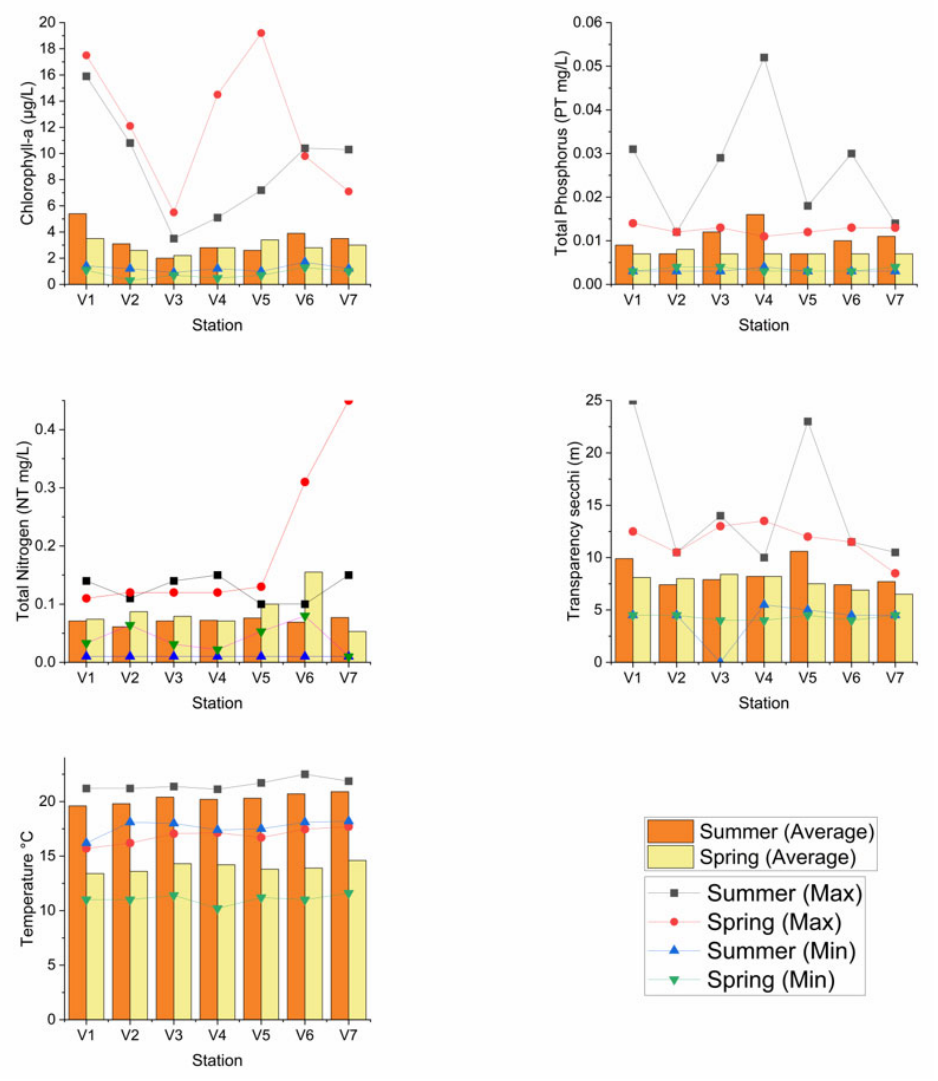
Figure 1. Behavior of limnological parameters in Lake Villarrica during summer and spring seasons. For the summer months (December, January, and February) and for the spring months (September, October, and November) were